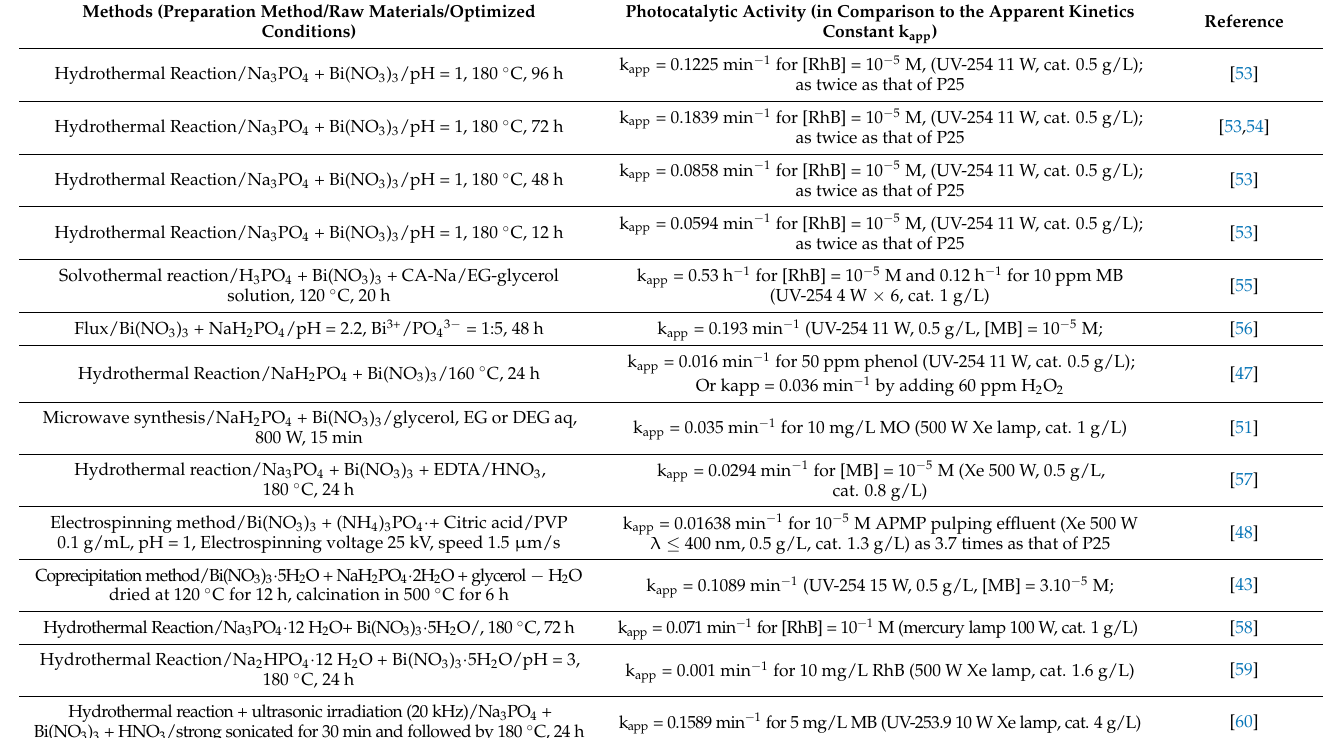
Table 1. Synthesis methods and photocatalytic properties of BiPO 4